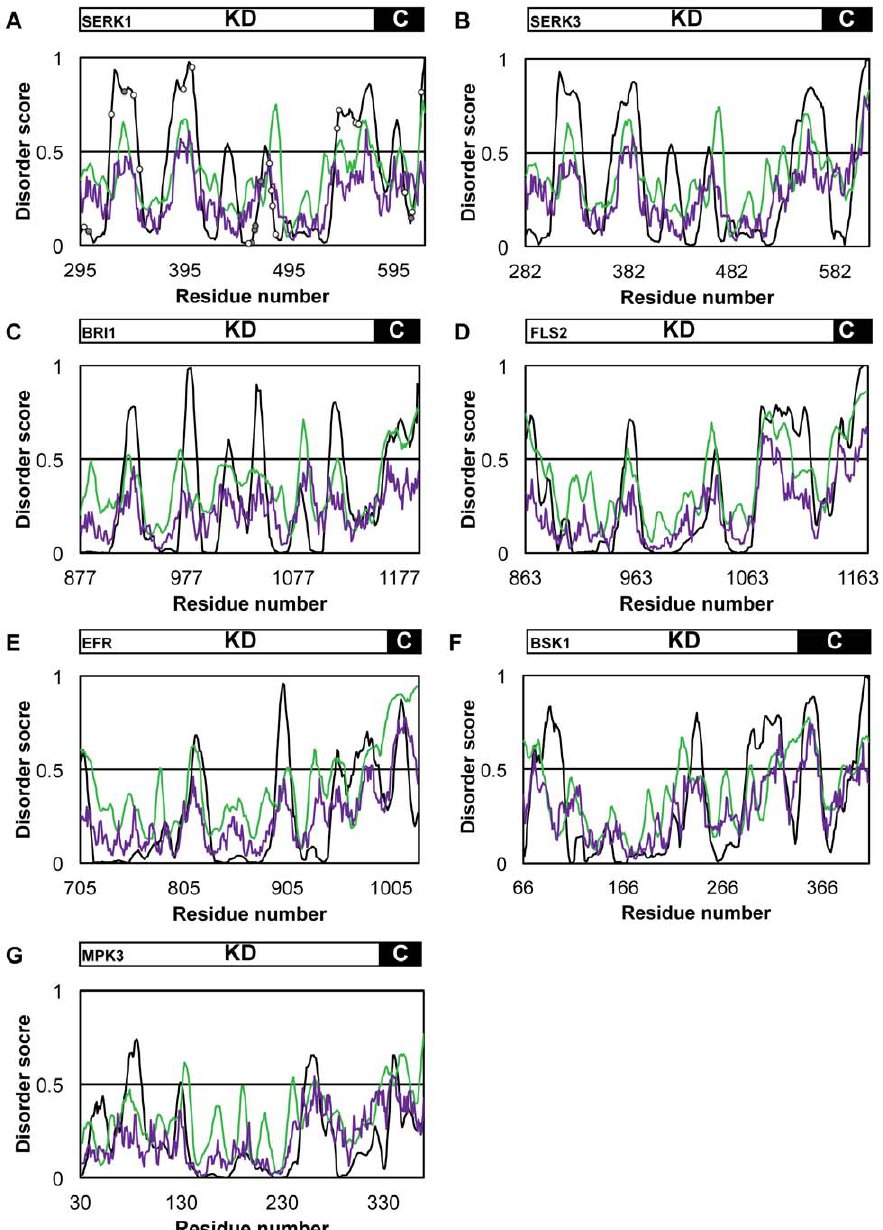
Figure 2. Predicted disorder within plant kinases using various disorder analyses programs. A disorder score lower than 0.5 indicates that a region is predicted to be ordered, whereas scores above 0.5 predict disordered protein sequences. Schematic above the graph indicates which part of the primary sequence belongs to the catalytic kinase domain (KD) or to the C-terminal tail (C). Disorder prediction of PONDR H VL-XT is depicted in black, VSL2B disorder analysis is depicted in green and IUPred disorder analysis in purple. ( A ) Disorder prediction for SERK1-KD. White dots indicate phosphorylation sites identified in vitro , grey dots indicate phosphorylation sites identified in planta [14]. Disorder profiles are also shown for kinase domains of ( B ) BAK1 (SERK3), a close paralog of SERK1, ( C ) BRI1, ( D ) FLS2 and ( E ) EFR, three main ligand binding plant RLK’s, and for ( F ) BSK1 and ( G ) MPK3, two cytoplasmic kinases.